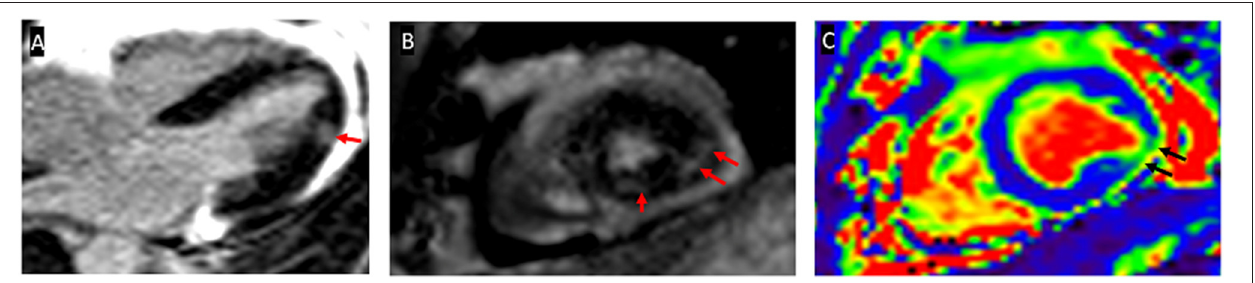
FIGURE 2 | Cardiac magnetic resonance imaging (C-MRI) imaging illustration of patient 1. (A) 4 cavity sections with a late enhancement of gadolinium and (B) transversal section showing infero-latero-medial mesomyocardic contrast (red arrows). (C) T2 mapping showing focal infero-latero-medial myocardial edema (black